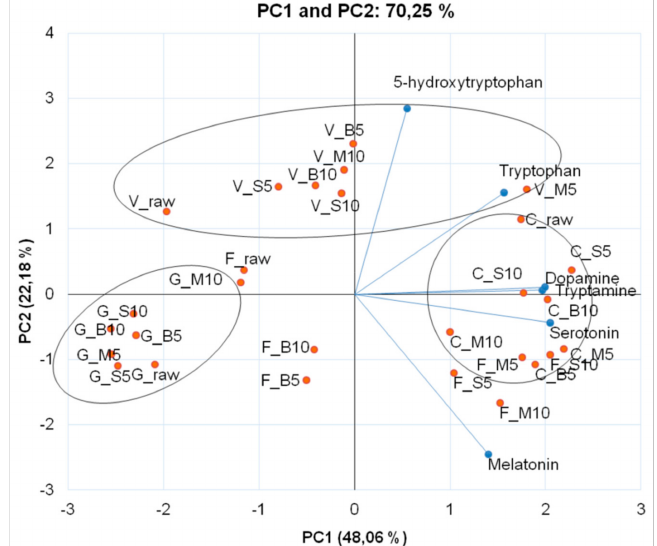
Figure 1. Bi-dimensional projection and scores of the amino acids tryptophan and 5-hydroxytryptophan, and the biogenic amines (serotonin, tryptamine, melatonin and dopamine) in thermally processed colored cauliflowers. The treatments are represented by the points, where initial letters represent the genotypes (V = ‘Verde di Macerata’, G = ‘Gra ffi ti’, F = ‘Forata’ and C = ‘Cheddar’) and the letters after underline represent the cooking methods (raw, B = boiling, S = steam and M = microwave) and the numbers represent the cooking times (5 min and 10